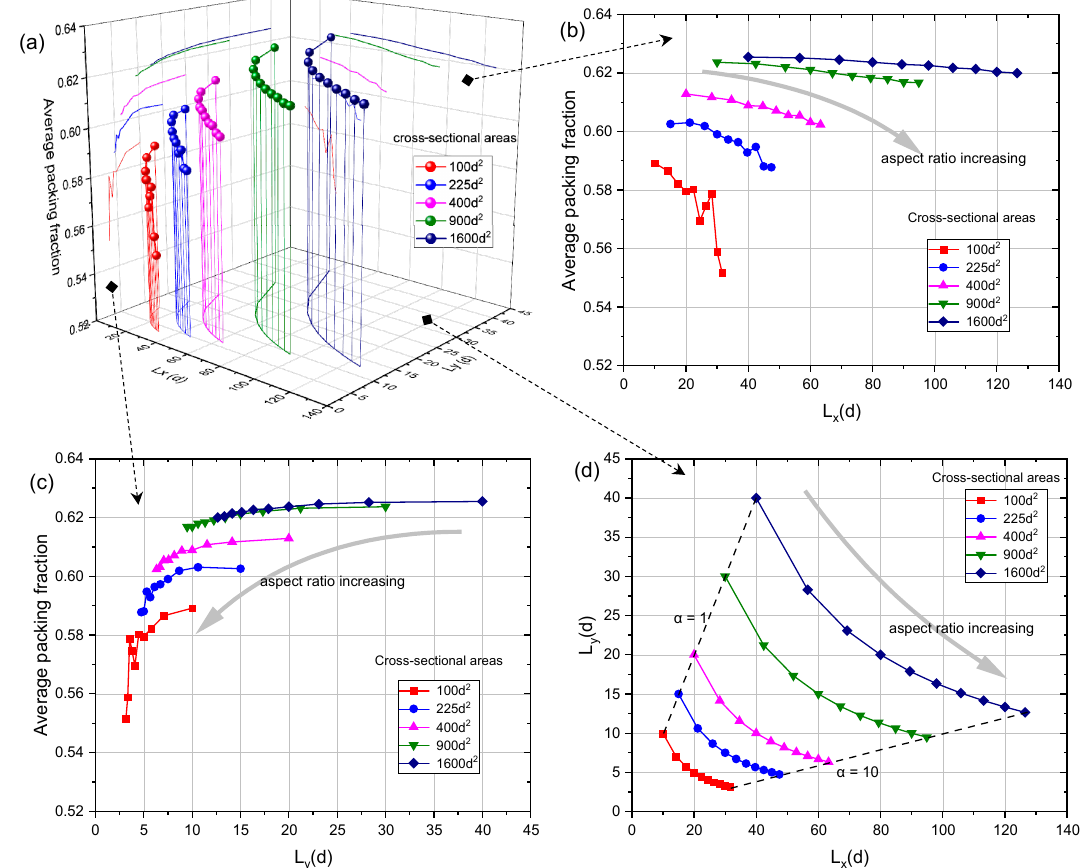
Figure 6. Average packing fraction of the rectangular packed pebble beds with various bed dimen- sions: ( a ) 3D views, ( b ) projected to the L x - γ avg plane, ( c ) projected to the L y - γ avg plane, ( d ) projected to the L x -L y plane (bottom plane) (Color online).